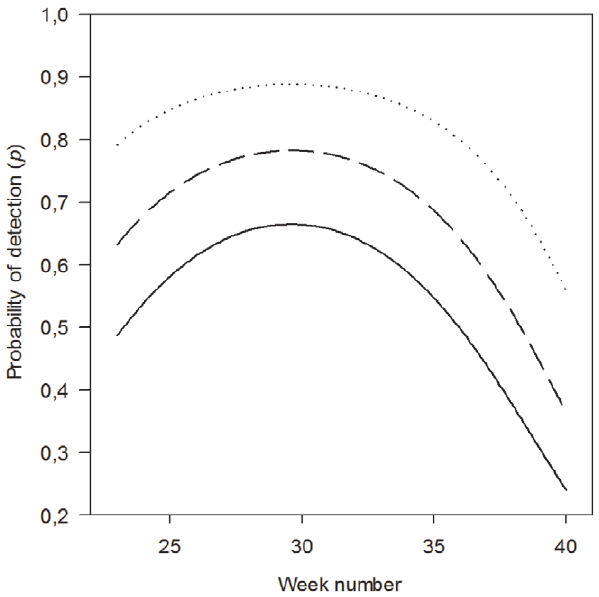
Figure 2. Probability of detection. The relationship between the probability of detection ( p ), week of the year (WEEK ‘ 2) and island perimeter (PERIM; 40 m=solid line, 358 m=broken line, 800 m=dot- ted